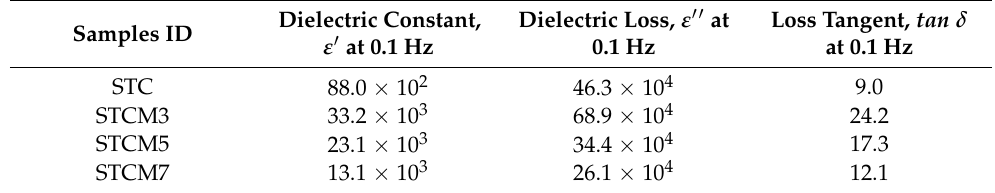
Figure 10. Graphs showing a ( a ) frequency dependence of ε ′ ( b ) ε ″ and ( c ) tan δ for STC and STCM materials at room temperature. Table 4. The dielectric constant, ( ε ′ ); dielectric loss, ( ε ″ ); and loss tangent, tan δ values at 0.1 Hz of STC and STCM materials.